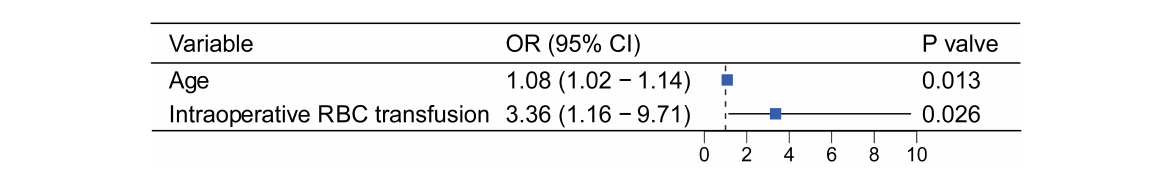
FIGURE3 Forest plot depicting multivariate logistic regression results for the postoperative hypoxemia. OR, odds ratio; CI, confidence